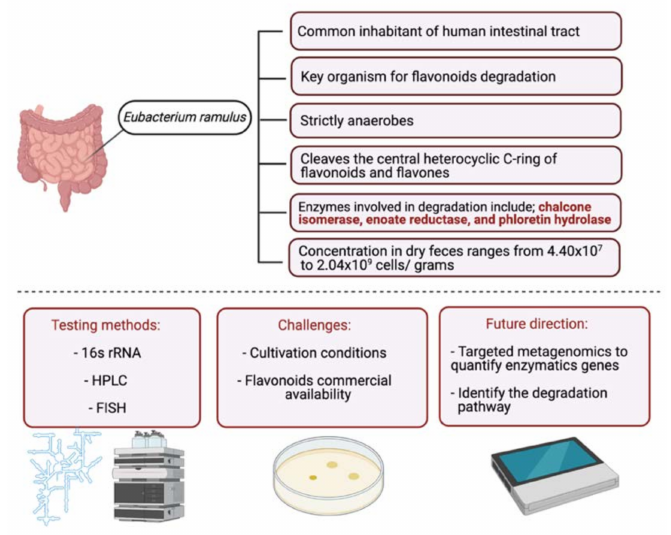
Figure 2. Schematic illustration of E. ramulus , a flavonoid degrading bacterium. The figure is divided into two parts. In the upper part, information about the bacteria is stated, and in the lower part, common testing methods, challenges with studying bacteria and efforts required to improve the field are listed. Created with BioRender.com (accessed on 3 August